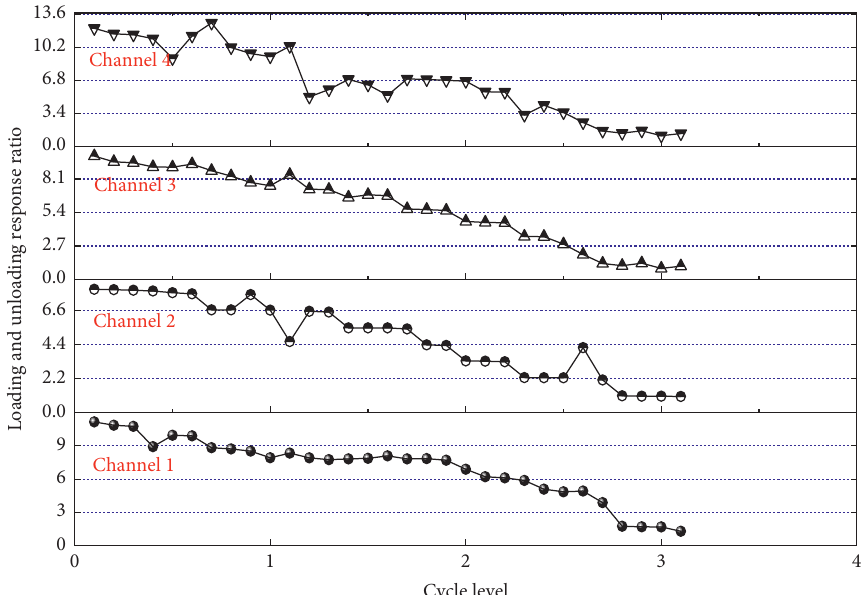
Figure 7: Y value of acoustic emission ringing number.